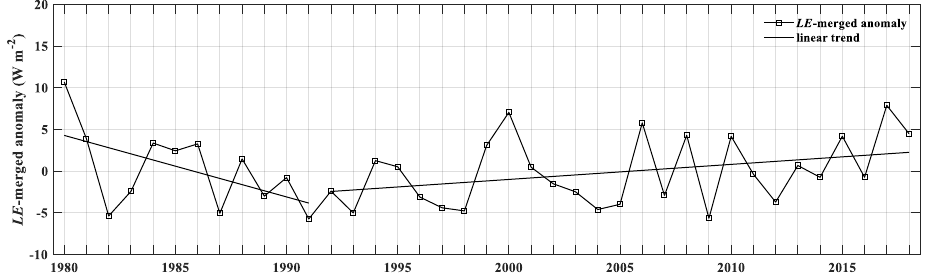
Figure 3. The temporal series of the summer latent heat flux anomaly estimated by the maximum entropy production model and the merged dataset ( LE -merged) at the Ali site from 1980 to 2018 and its linear trends.